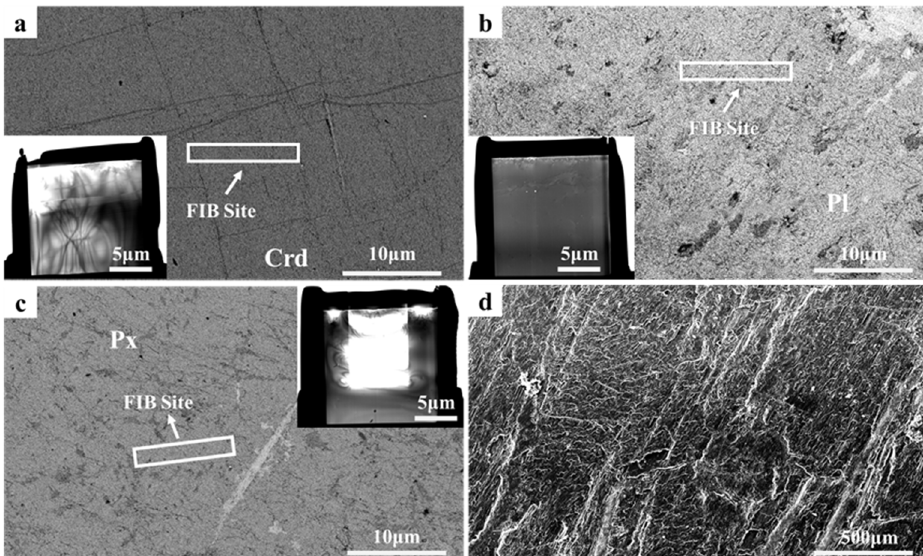
Figure 3. SEM back-scattered electron images of ( a ) cordierite, ( b ) plagioclase, and ( c ) pyroxene. The red rectangles indicate the extraction locations of the FIB samples. The inserts in the bottom left of ( a , b ) and top right of ( c ) show scanning transmission electron microscope images of the FIB cross-section. ( d ) Secondary electronic image of the gabbro surface after irradiation.